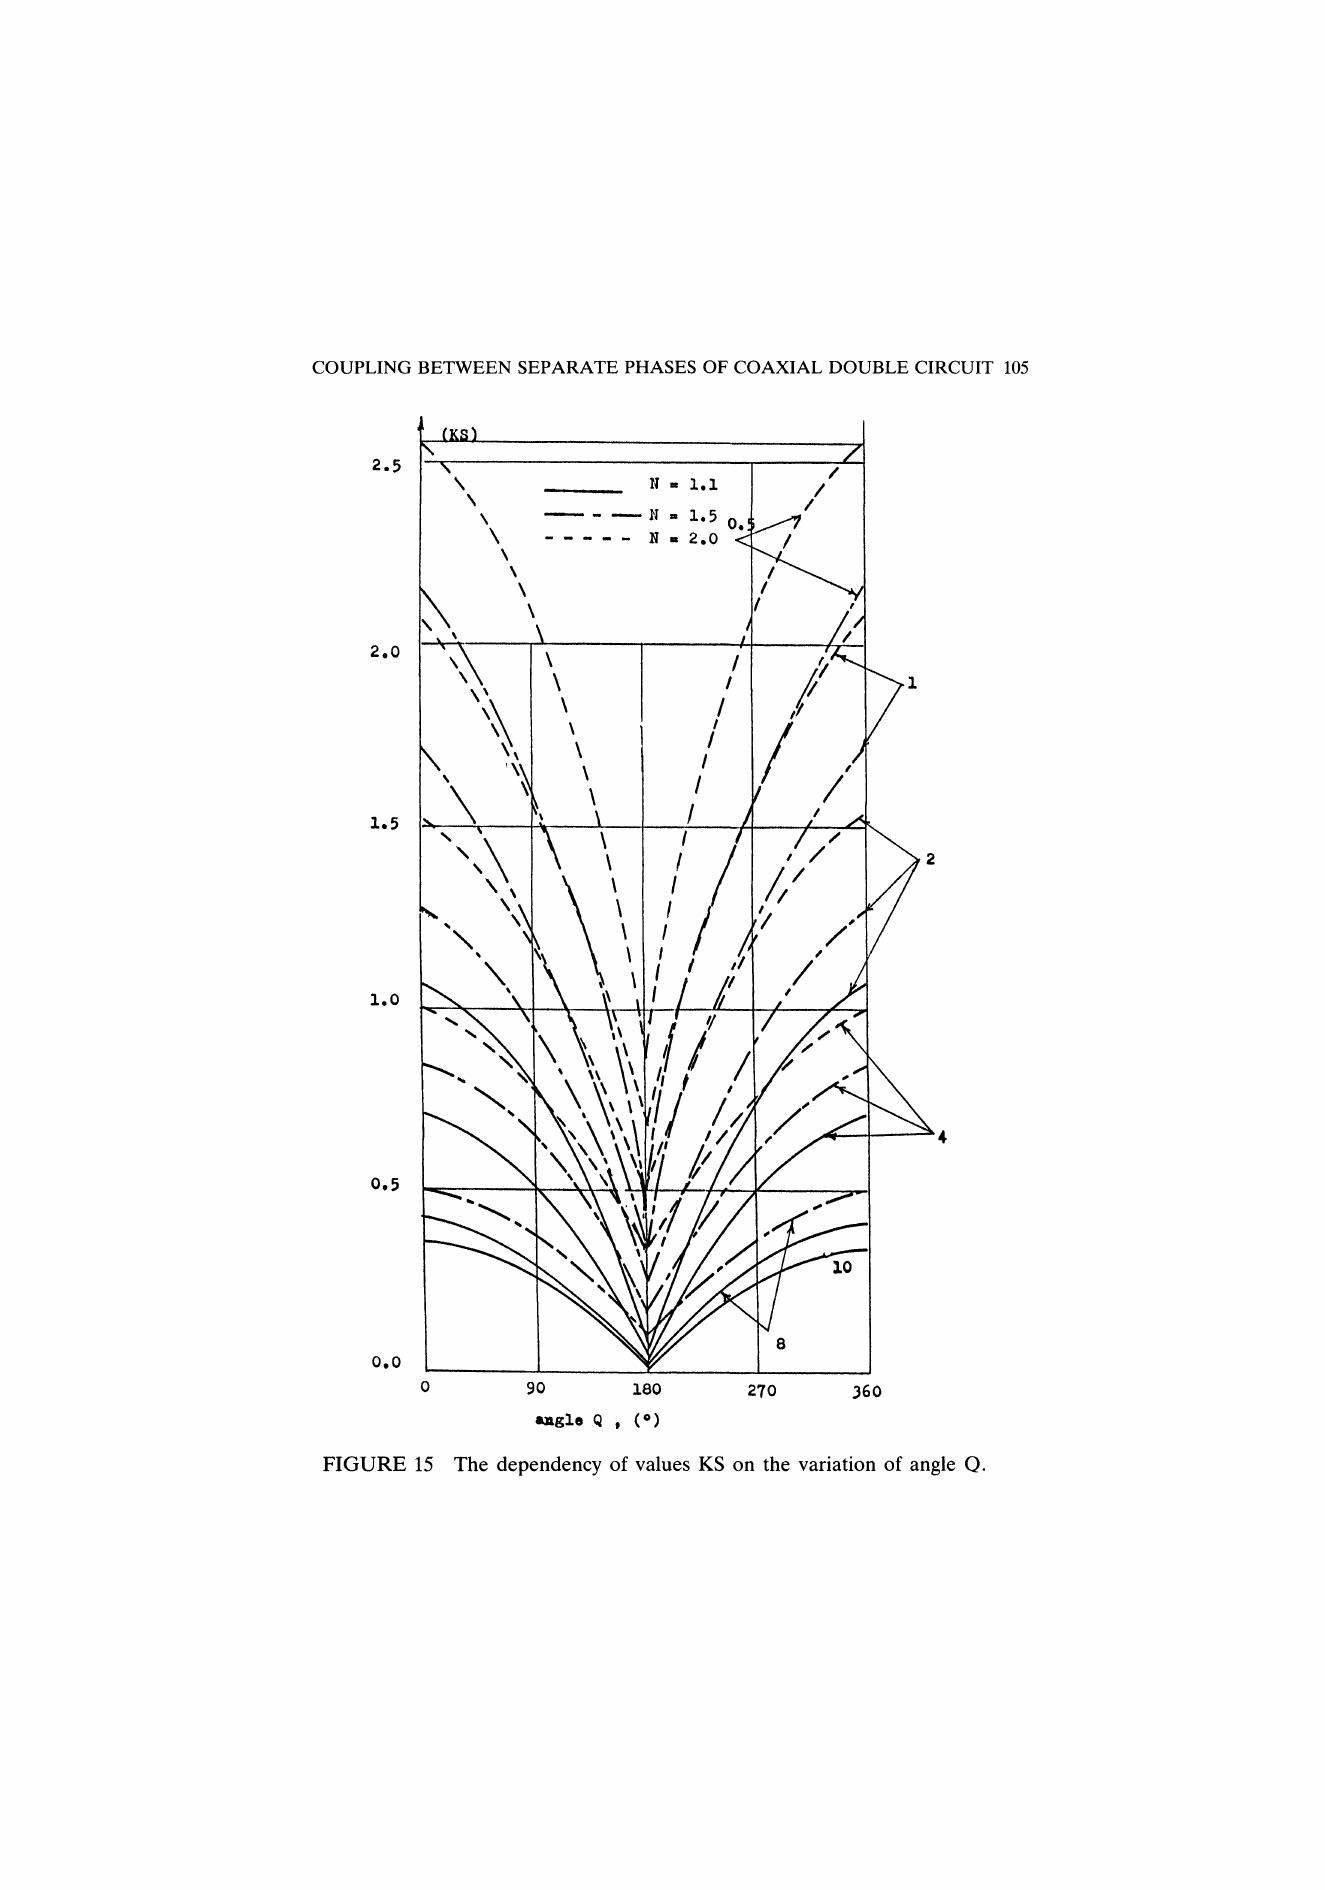
FIGURE 15 The dependency of values KS on the variation of angle